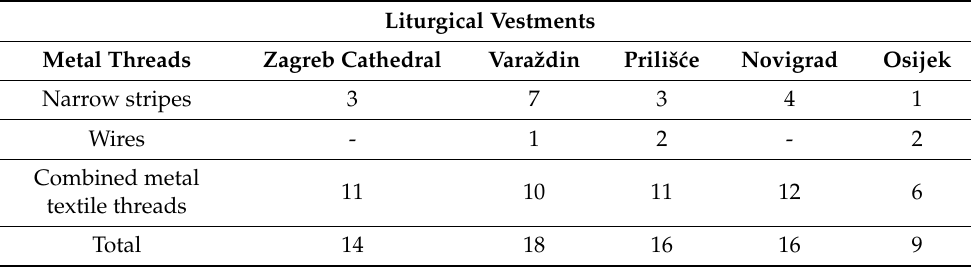
Figure 3. Three different metal threads found on historical textiles in Croatia investigated by SEM- EDX: ( a ) metal narrow stripe; ( b ) metal wire; ( c ) combined metal textile threads called “srma”. Metal threads can be woven into textiles, part of a fringe hanging from textiles, but also it can be in the decorative ribbons stitched on textiles. There are 156 samples of metal threads, 73 are from liturgical vestments (Table 1) and 83 from folk costumes (Table 2). Most of the collected samples are combined metal textile threads (114), and the least are wires (16), while 26 are narrow stripes. Table 1. Table of all metal thread samples from liturgical vestments.